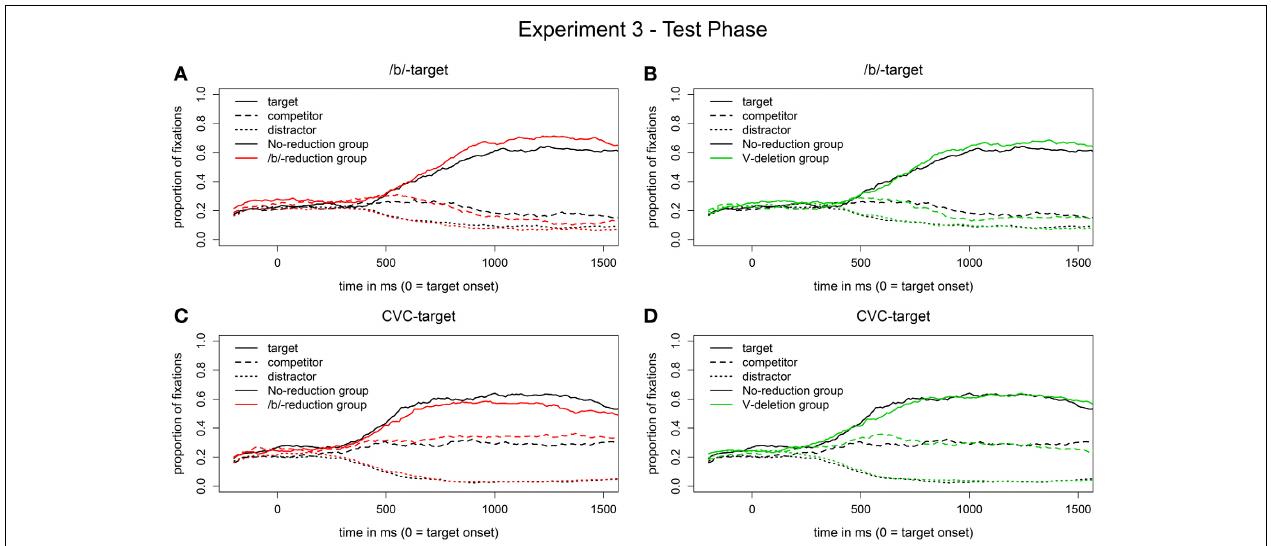
FIGURE 7 | Proportion of fixations in the segmental reduction condition [reduced /b/-words in auditory input, visual /b/-targets on screen; (A,B)] and in the syllabic reduction condition [vowel-deleted words in auditory input, visual CVC-targets on screen; (C,D)] in the test phase of Experiment